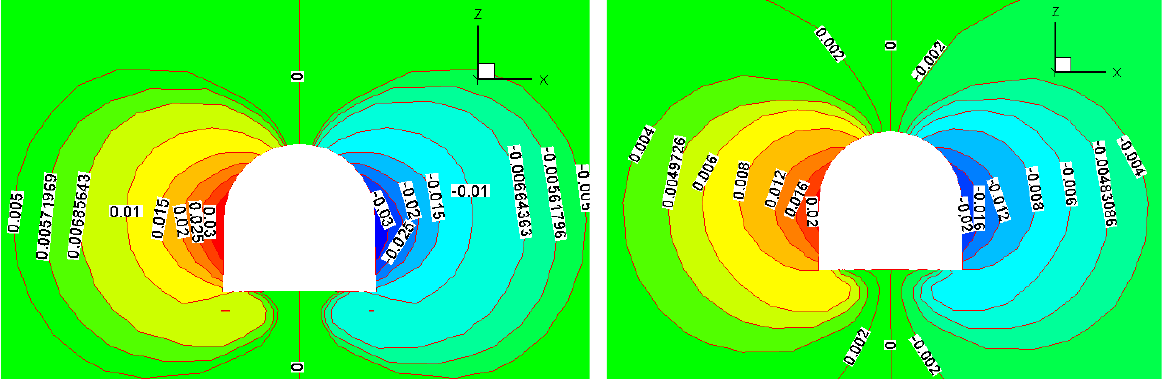
Figure 13. Two sides displacement contour of the test roadway at an excavation depth of 12 m.